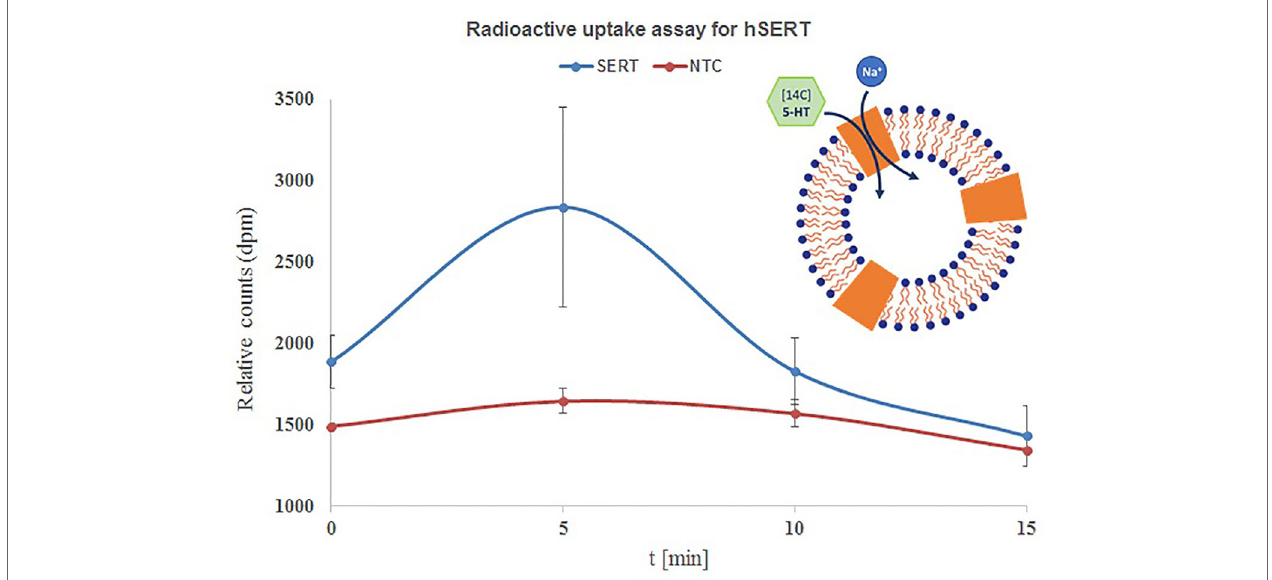
FIGURE 4 | Time course uptake of 5-HT by hSERT synthesized by repetitive batch mode and incorporated in microsomes. Microsomal fraction from 3x repetitive batch synthesis of NC-hSERT was incubated with [14C] 5-HT in uptake buffer and stopped by addition of stop buffer at different points in time; centrifugation speed for fractionation was 16,000xg, sucrose concentration for microsome washing was 2.5 M; the detergent resuspended microsomal fraction of the second fractionation underwent liquid scintillation counting. Bars show mean counts of duplicate measurements with error bars showing the